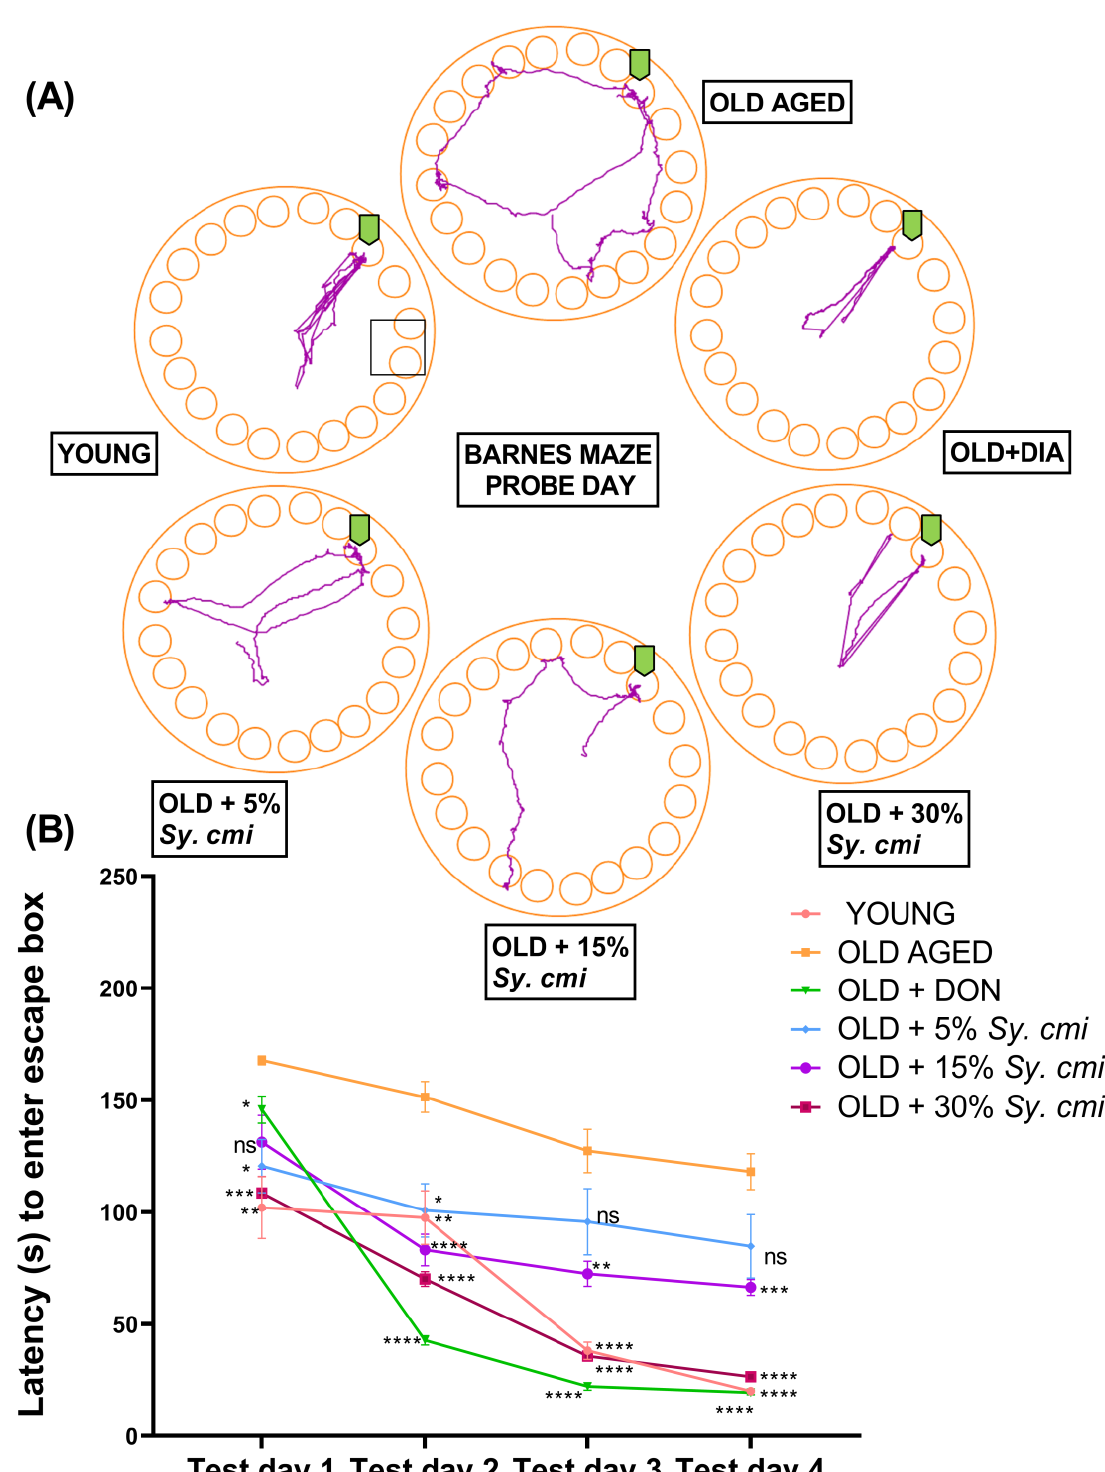
Figure 8. The mice ( n = 8) supplemented with 5, 15, and 30% dilutions of Sy. cmi for 16 months were tested for learning and memory in the Barnes maze test, and the animals’ cognitive ability was tested by monitoring their ability to locate the escape hole in consecutive 5 days. The animals’ activity was expressed as ( A ) representative track plots of animals from the respectively treated group and ( B ) latency to enter the escape hole. The outcomes of all groups were compared with the aged control group and * p < 0.05, ** p < 0.01, *** p < 0.001, **** p < 0.0001 were considered statistically significant while ns showed non-sgnificant outcomes for all data presented as mean ±